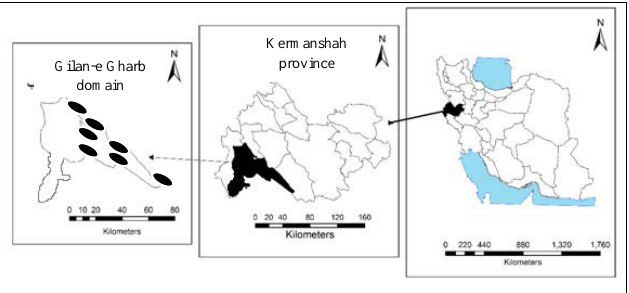
Figure 1: The study area in Iran and Kermanshah